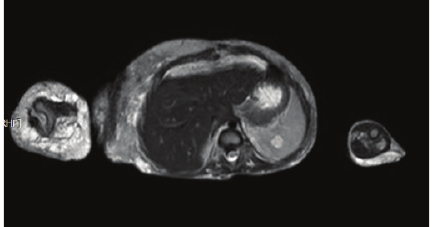
Figure 8: MRI of the abdomen showed the hemangioma in the